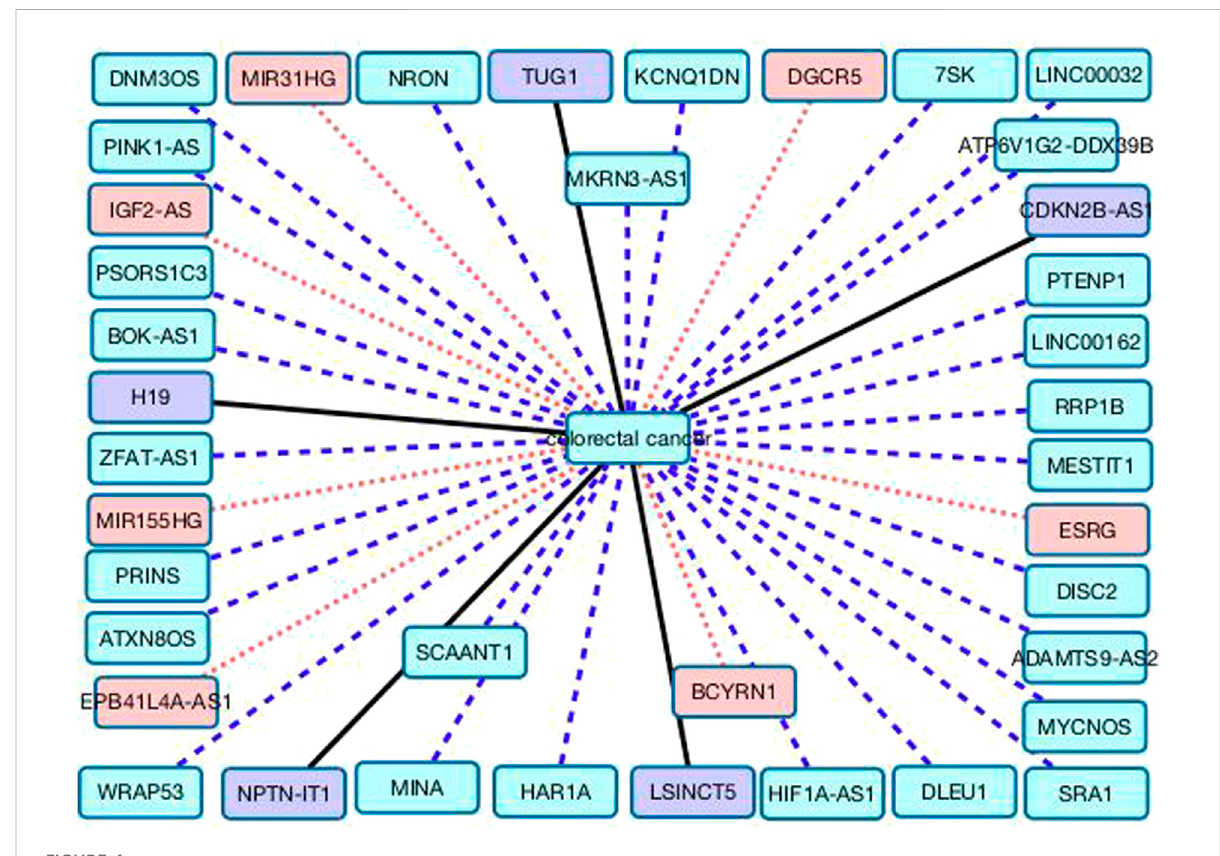
FIGURE 4 The associations between the remaining 39 lncRNAs and colorectal